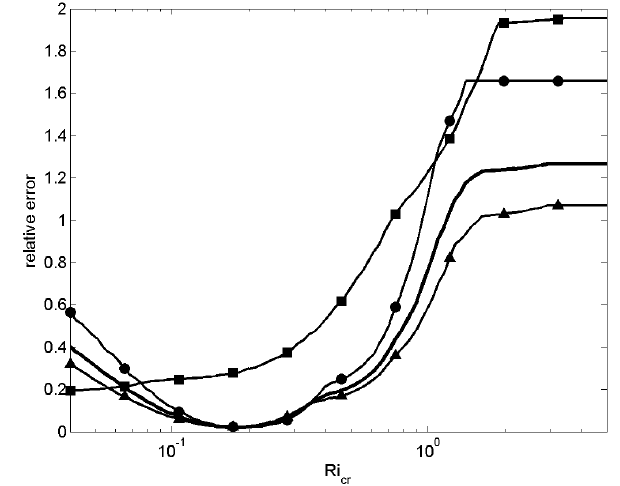
Figure 4. The relative error ( h TM − h LES ) / h LES , as functions of Ri cr for the nocturnal stable (squares), conventionally neutral (circles) and long-lived stable (triangles) PBL averaged over all correspond- ing runs in DATABASE64. The bold line without symbols is the mean line for the later two types of the